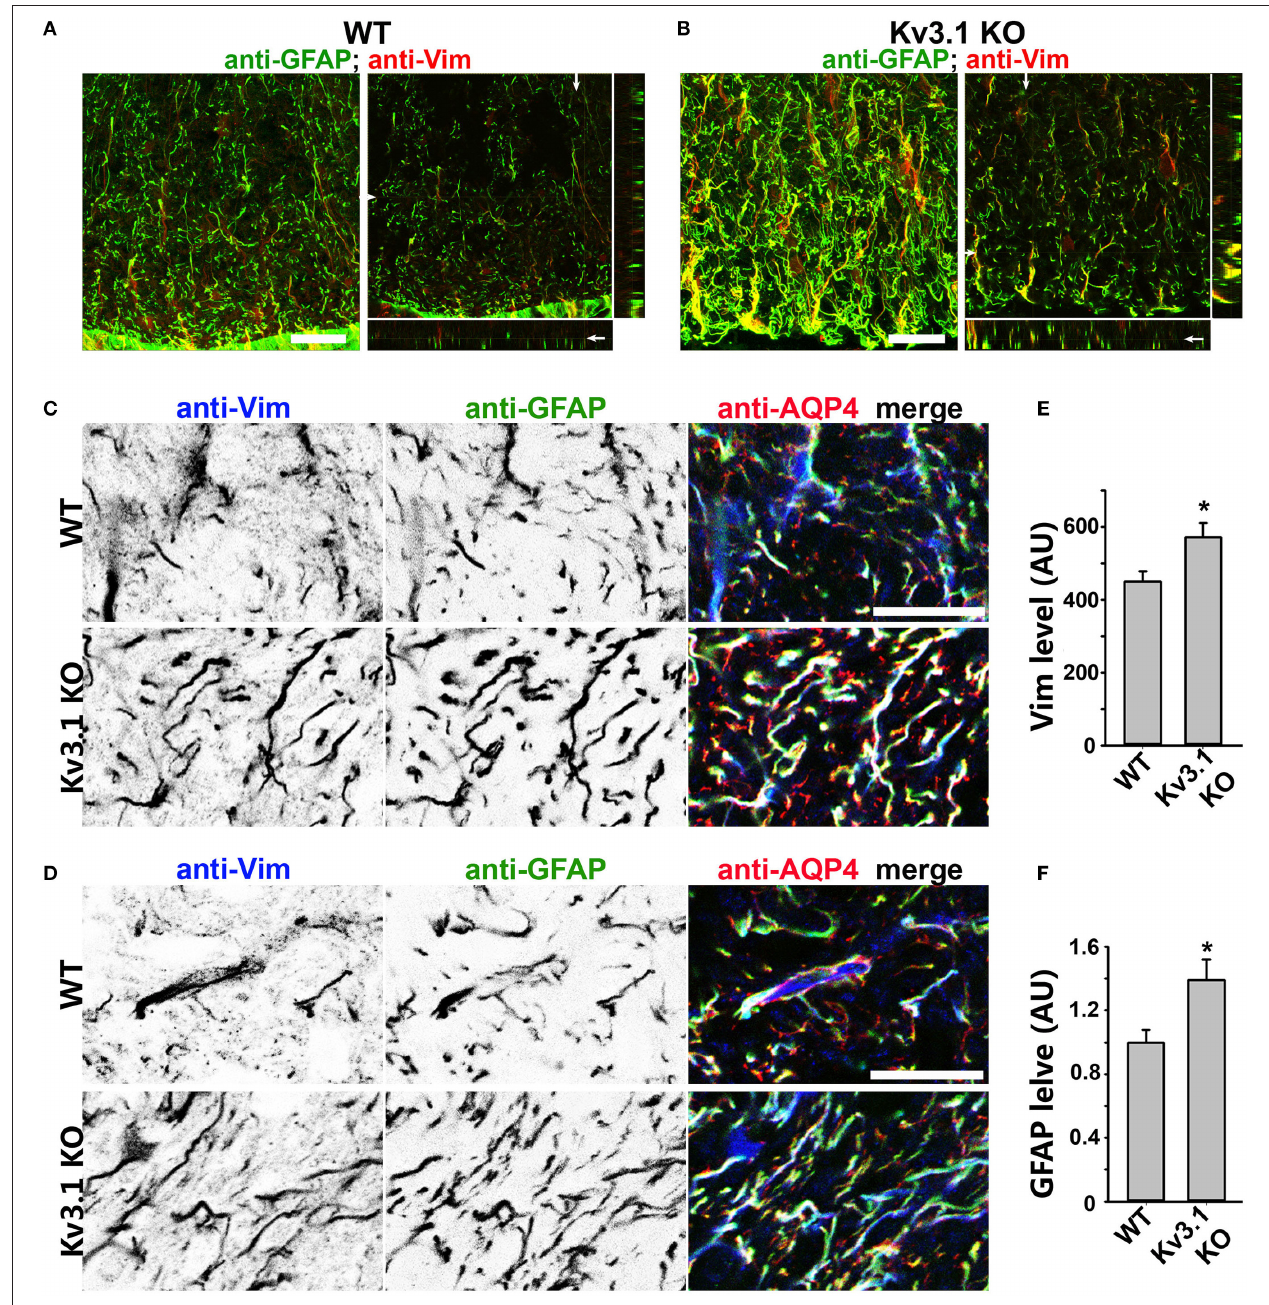
FIGURE 4 | Upregulation of astrocytic intermediate filaments in Kv3.1 KO mice. (A) Cross sections of ventral SCWM in WT mice were costained for GFAP (green) and Vim (red). The collapsed 2D image is on the left, and three cross sections are on the right. (B) Cross sections of ventral SCWM in Kv3.1 KO mice were costained for GFAP (green) and Vim (red). Scale bars, 200 µ m. (C) , Increased expression of Vim (inverted gray scale image on the left; blue in the merged image on the right), GFAP (inverted gray scale image in the middle; green in the merged image on the right), and AQP4 (red) in dorsal SCWM of Kv3.1 KO mice (bottom) compared to that of WT mice (top). (D) Increased expression of astrocytic proteins as in (C) in ventral SCWM. Scale bars, 100 µ m. Summary of expression levels of Vim (E) and GFAP (F) in WT and Kv3.1 KO mice. Unpaired Student t –test: * p < 0.05. n = 50. The results were from 3 Kv3.1 KO and 4 WT